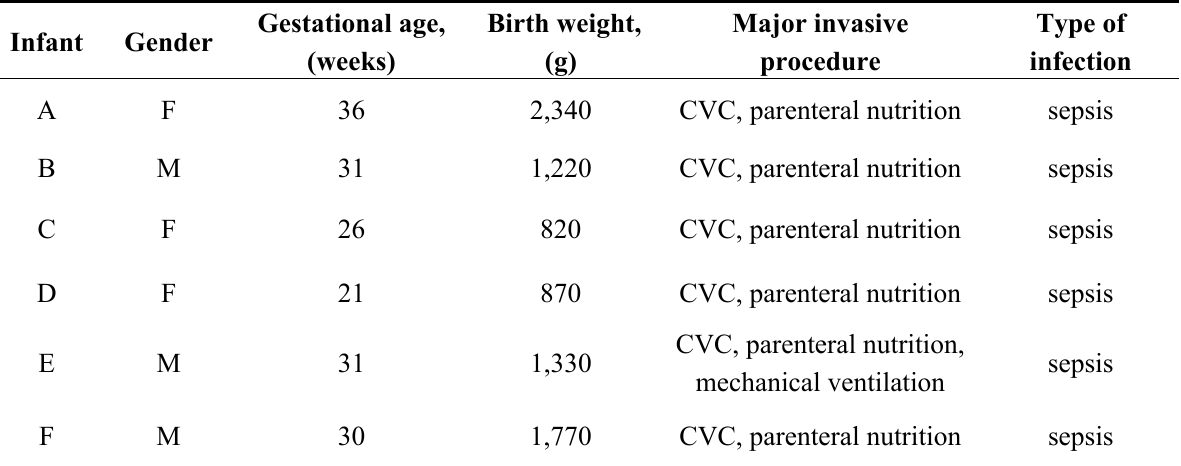
Table 2. Baseline characteristics and clinical outcomes of the 6 infants with Ampicillin/Piperacillin-resistant Klebsiella Infection.